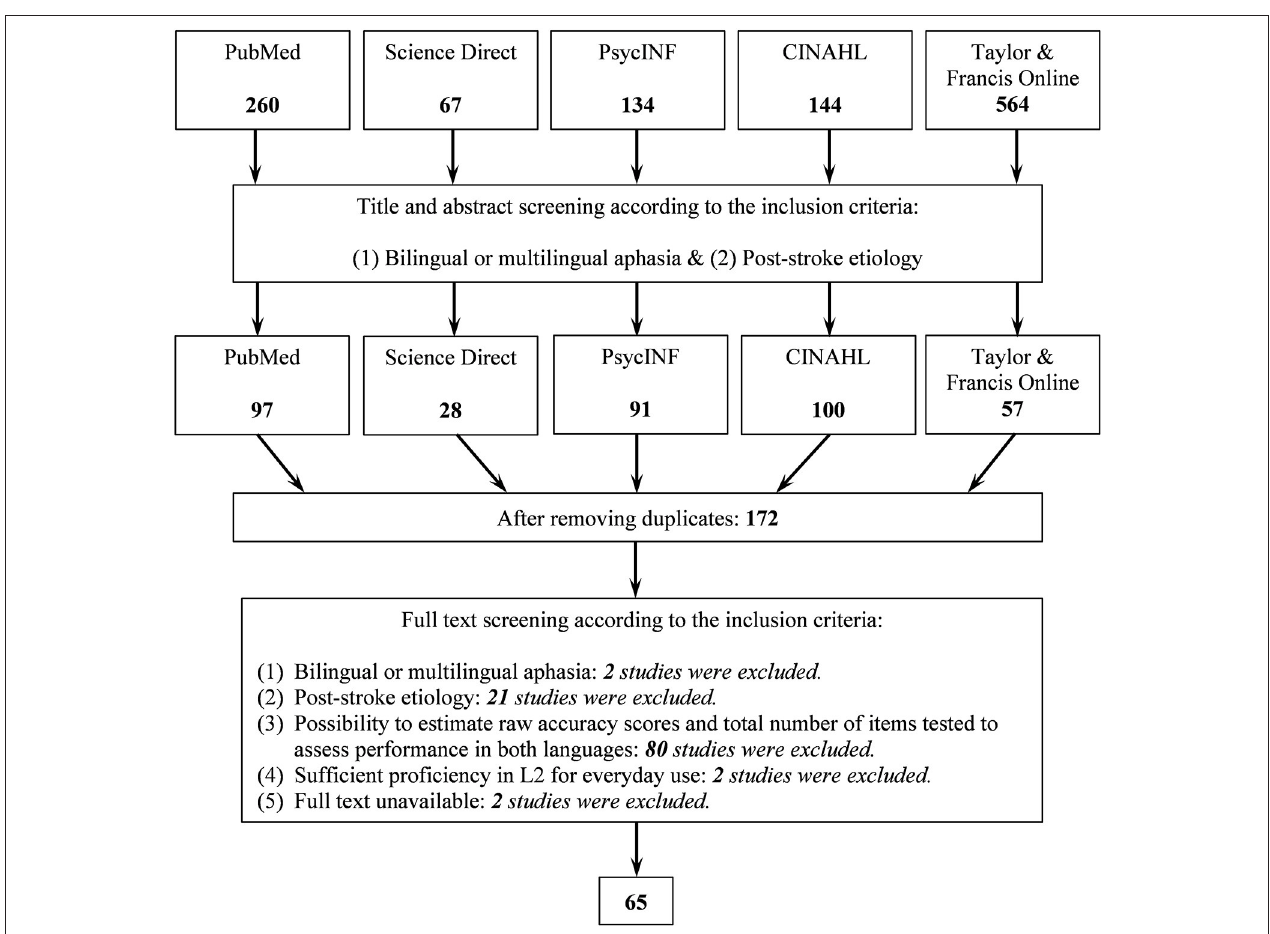
FIGURE 1 | Flowchart of the search process. Numbers show how many studies were included at each stage.